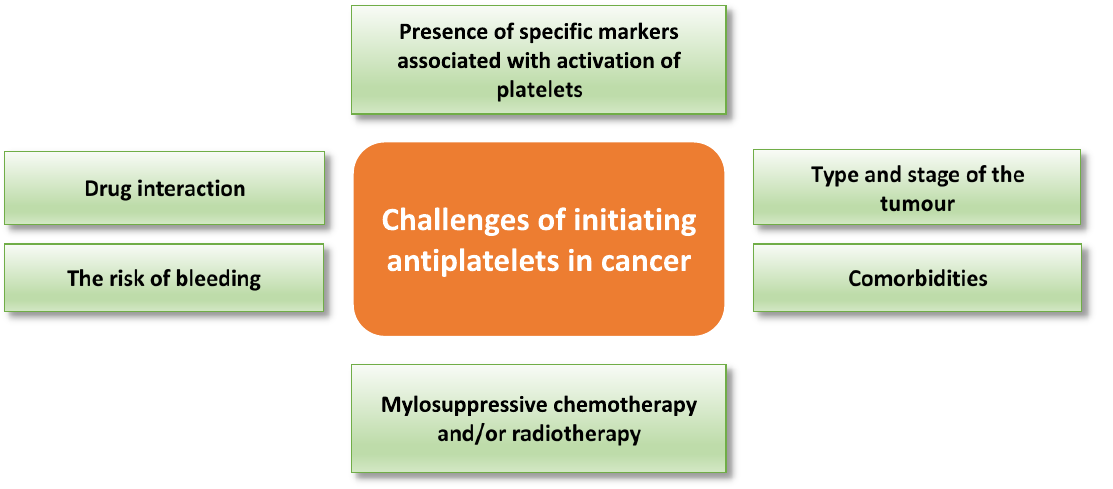
Figure 4. Potential challenges in targeting platelets during cancer therapy. Clinical implementation of antiplatelets in cancer may face several confounders which can be patient-related or therapy-related.